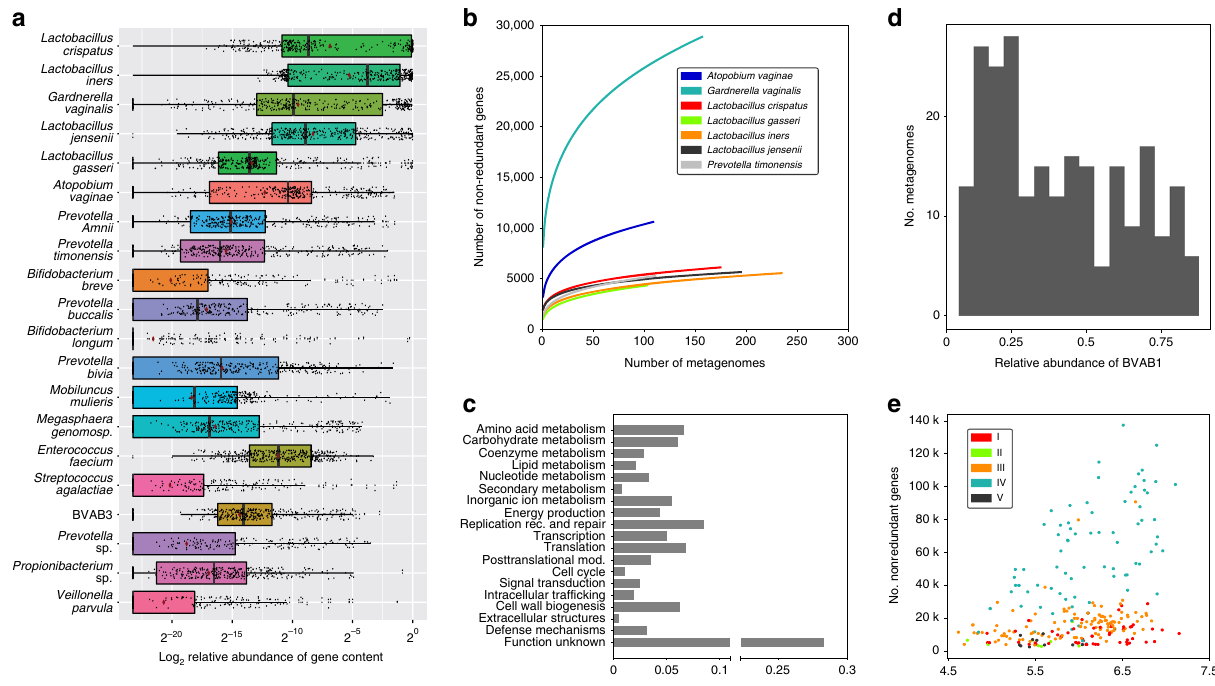
Fig. 3 Taxonomic and functional composition of vaginal microbiome in VIRGO. a Top 20 species with the most abundant gene content in VIRGO. The logarithm of the ratio of the gene content of a species over the entire community to the base 2. Plotted are interquartile ranges (IQRs, boxes), medians (line in box), and mean (red diamond). b Species-speci fi c metagenome accumulation curves for the number of non-redundant genes. c Functional distribution of non-redundant genes in VIRGO. Functional categories were de fi ned using EggNOG (v4.5) 59 . d Prevalence of BVAB1 in metagenomes using a minimum number of genes threshold of 50% of the estimated BVAB1 genome size. A gene was present if ≥ 3 reads mapped to it. e Relationship between the depth of sequencing and the number of bacterial non-redundant genes identi fi ed using VIRGO. Each point is a separate metagenome and is color-coded according to community state